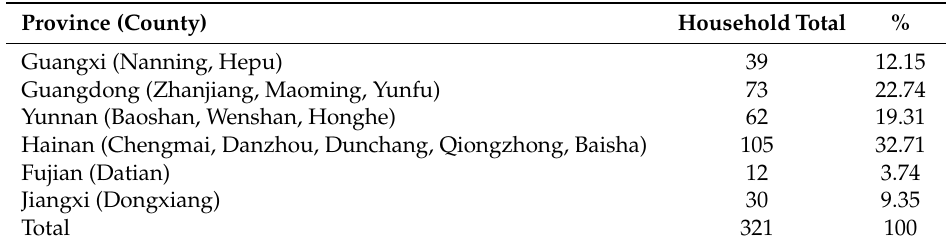
Table 2. Distribution of respondents in each province.